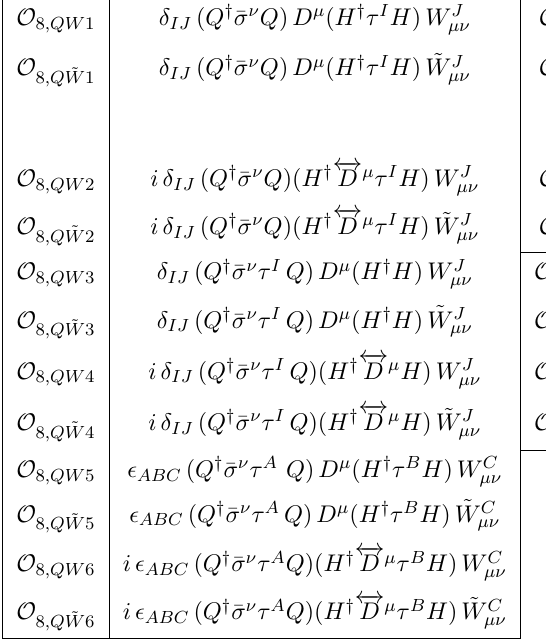
Table 7 . The 20 ( N f = 1) operators involving quark, W -boson and Higgs (cid:12)elds that are relevant for the phenomenological study of pp ! h W (cid:6)